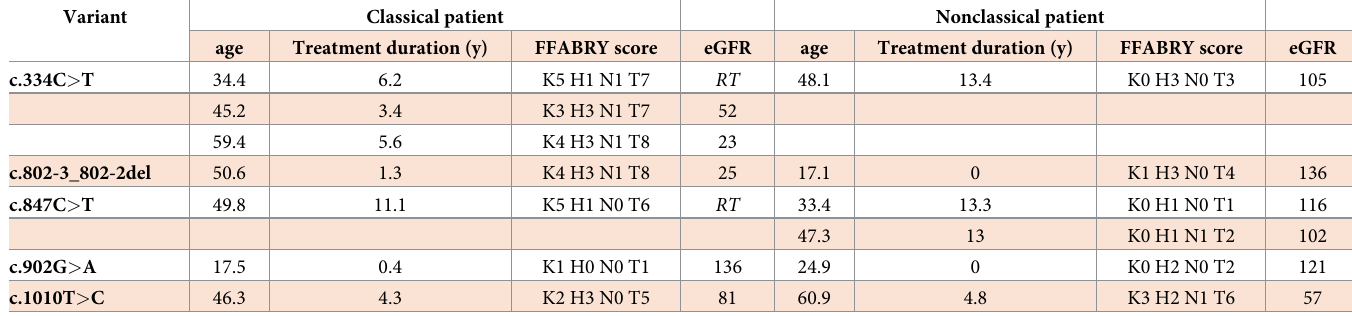
Table 4. Characteristics of patients with genetic variants observed in both classical and nonclassical groups (eGFR: Estimated glomerular filtration by CKD-EPI equation in ml/min/1.73m 2 ; RT: Renal transplant).